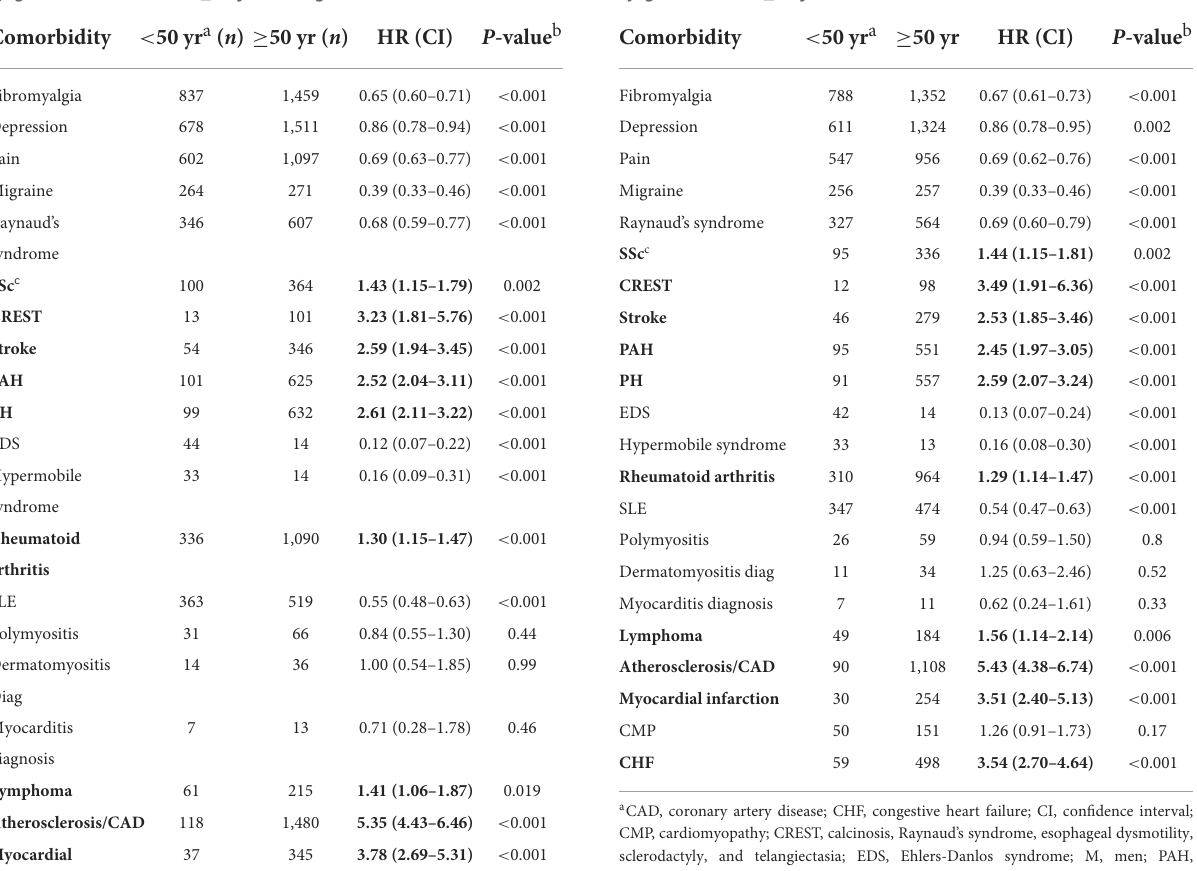
TABLE 13 Relative risk of developing a comorbidity in women with Sjögren’s disease ≥ 50 years ( n =